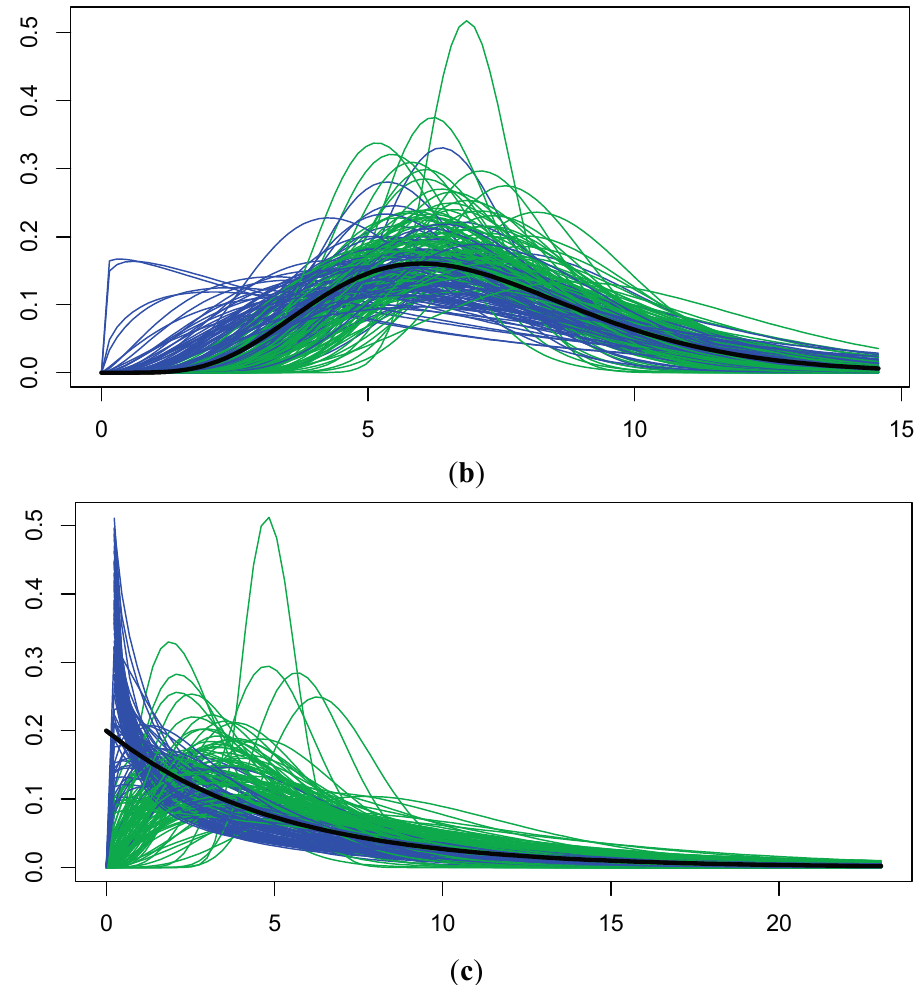
Figure A2. ( a ) Original Gamma(3, 3) pdf (black) for simulated data with n = 12 with an average of three NDs, and pdf’s estimated by the EM method (blue) and the GROS method (green); ( b ) Original Gamma(7, 1) pdf (black) for simulated data with n = 12 with an average of three NDs, and pdf’s estimated by the EM method (blue) and the GROS method (green); ( c ) Original Gamma(1, 0.2) pdf (black) for simulated data with n = 12 with an average of three NDs, and pdf’s estimated by the EM method (blue) and the GROS method (green). Simulations using 10,000 iterations were also conducted to numerically compare the parameter estimates to the true parameter values and to compare the calculated 95%-confidence–95%-tolerance UTLs to the 95 th percentile of the original gamma distribution. Table A1 shows the results of these